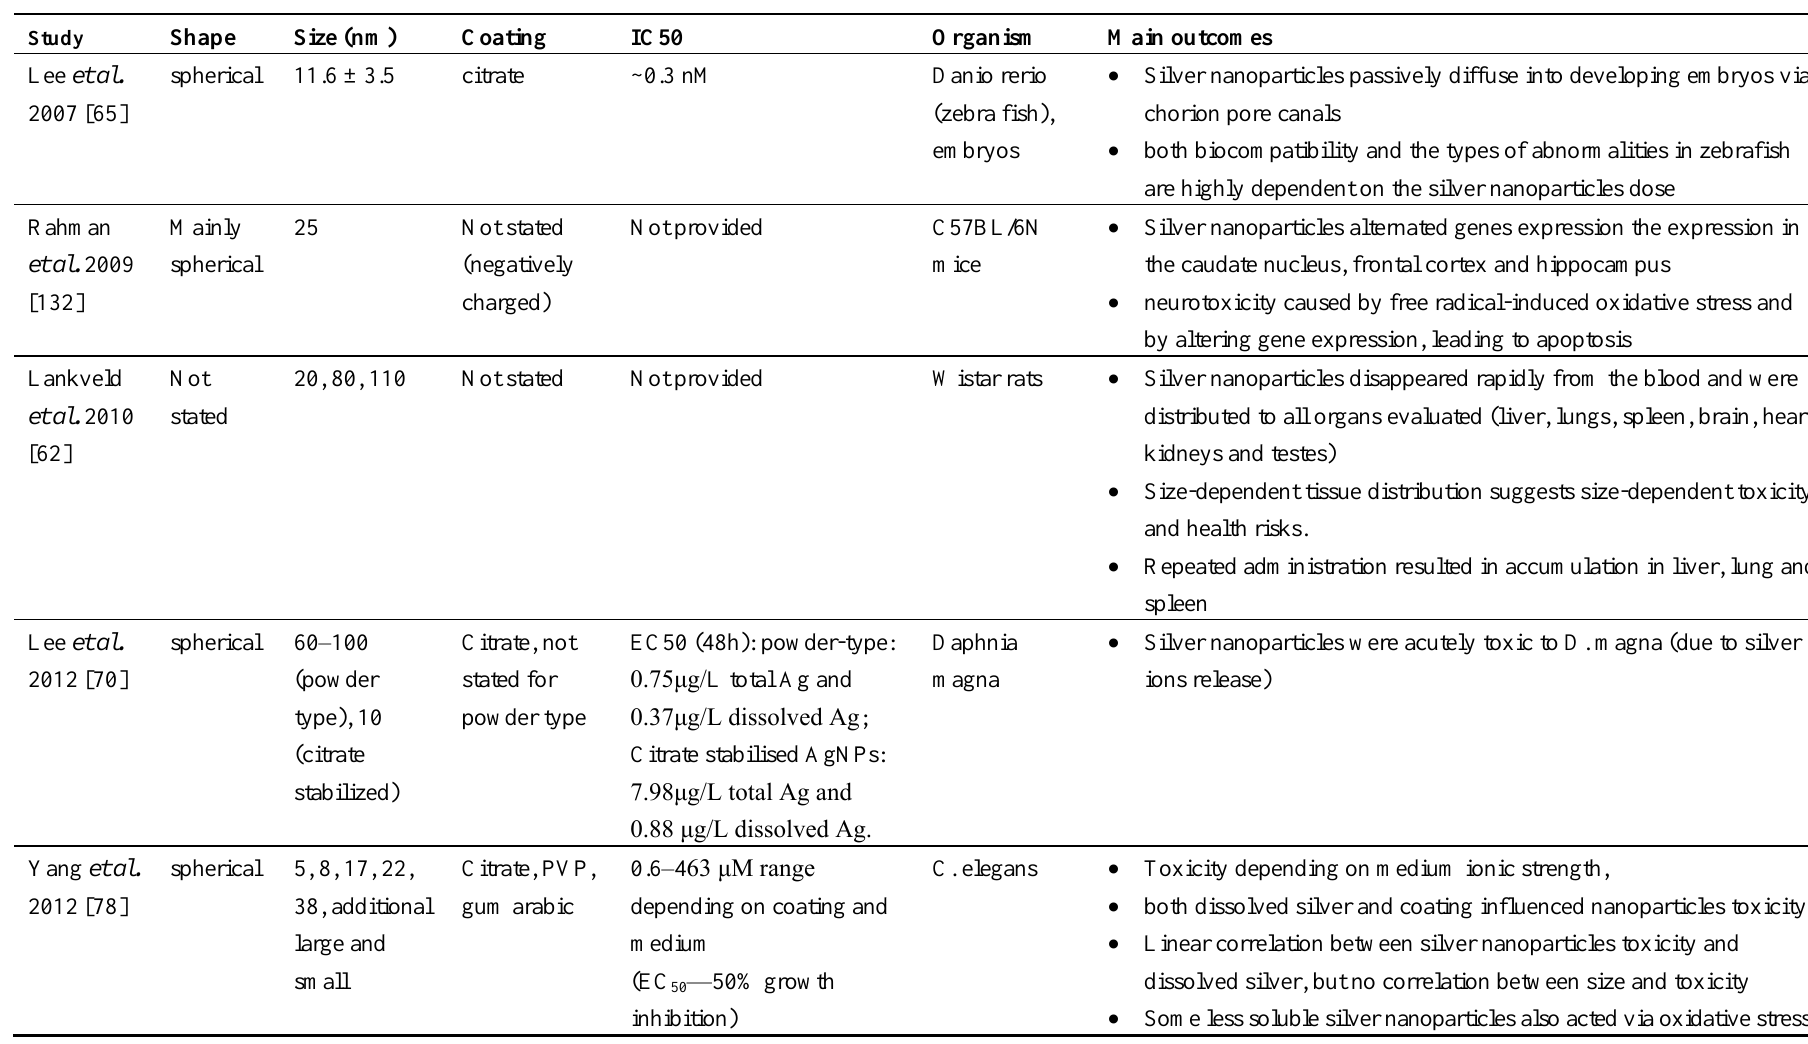
Table A2. Silver nanoparticles used in in vivo biological experiments and their